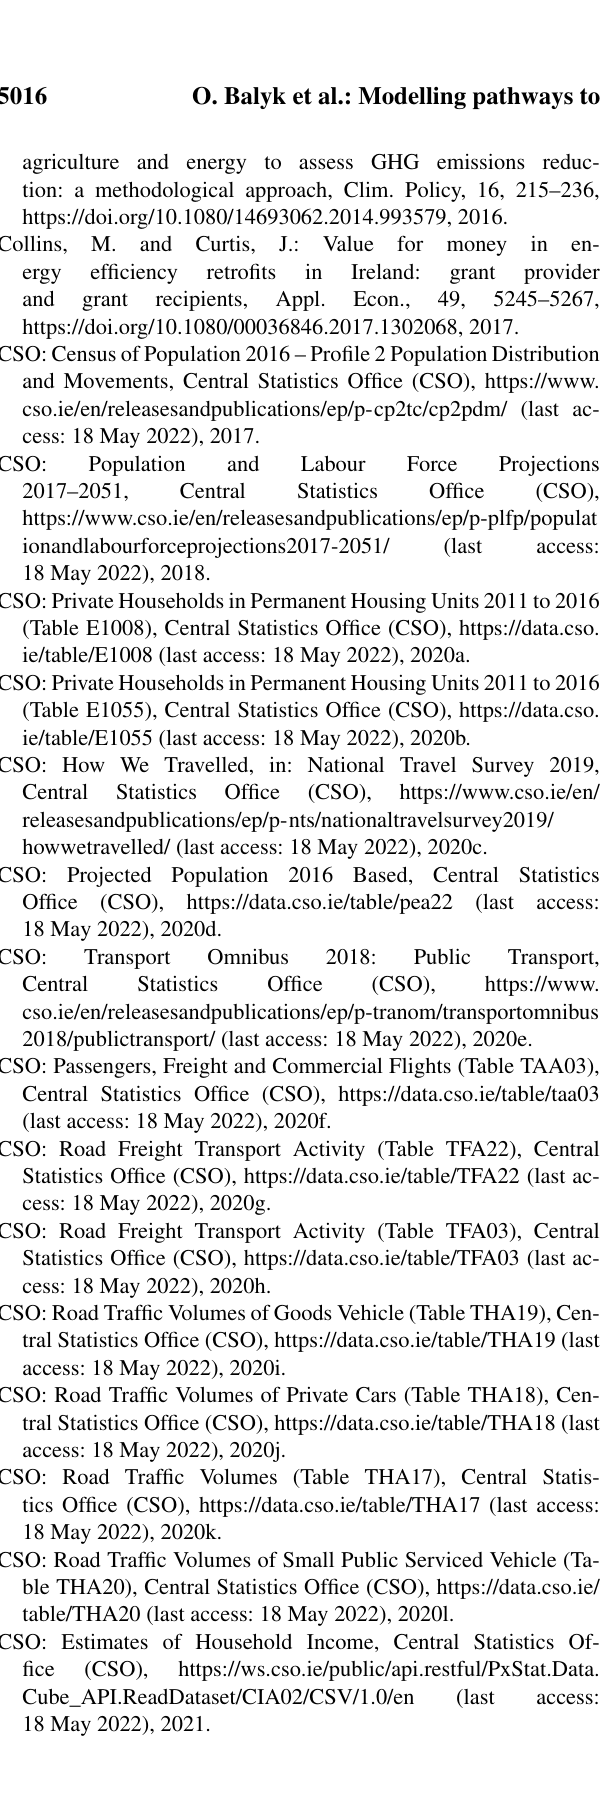
CSO: Passengers, Freight and Commercial Flights (Table TAA03), Central Statistics Office (CSO), https://data.cso.ie/table/taa03 CSO: Road Freight Transport Activity (Table TFA22), Central Statistics Office (CSO), https://data.cso.ie/table/TFA22 (last ac- CSO: Road Freight Transport Activity (Table TFA03), Central Statistics Office (CSO), https://data.cso.ie/table/TFA03 (last ac- CSO: Road Traffic Volumes of Goods Vehicle (Table THA19), Cen- tral Statistics Office (CSO), https://data.cso.ie/table/THA19 (last CSO: Road Traffic Volumes of Private Cars (Table THA18), Cen- tral Statistics Office (CSO), https://data.cso.ie/table/THA18 (last CSO: Road Traffic Volumes (Table THA17), Central Statis- tics Office (CSO), https://data.cso.ie/table/THA17 (last access: CSO: Road Traffic Volumes of Small Public Serviced Vehicle (Ta- ble THA20), Central Statistics Office (CSO), https://data.cso.ie/ table/THA20 (last access: 18 May 2022), 2020l. CSO: Estimates of Household Income, Central Statistics Of- fice (CSO),